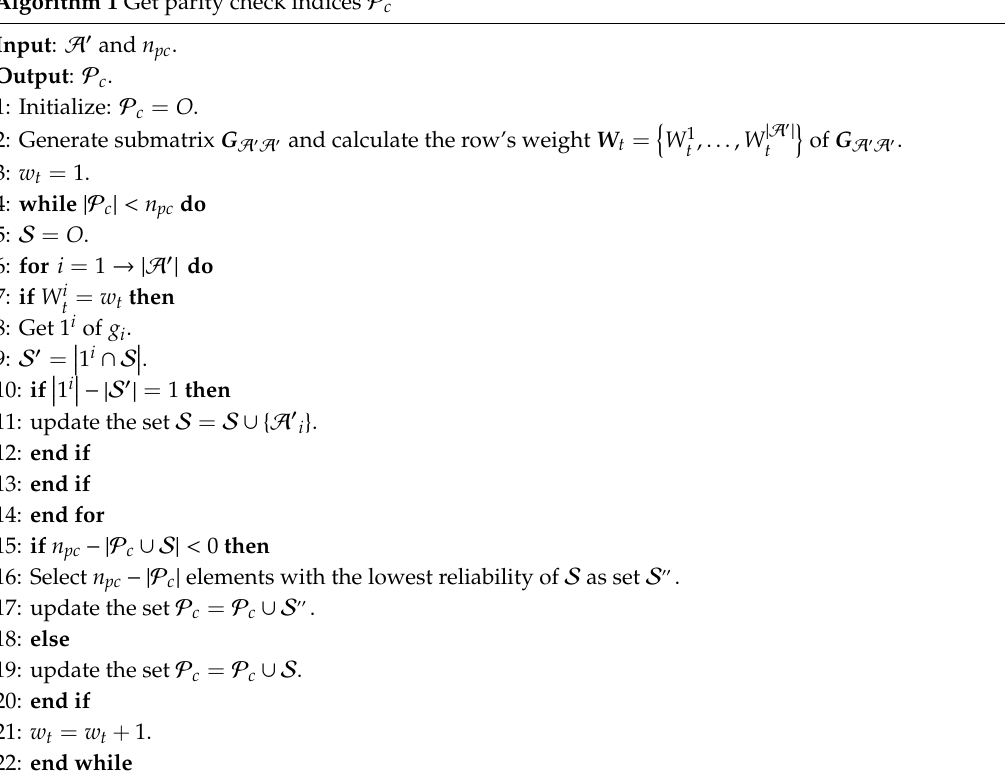
Algorithm 1 Get parity check indices P